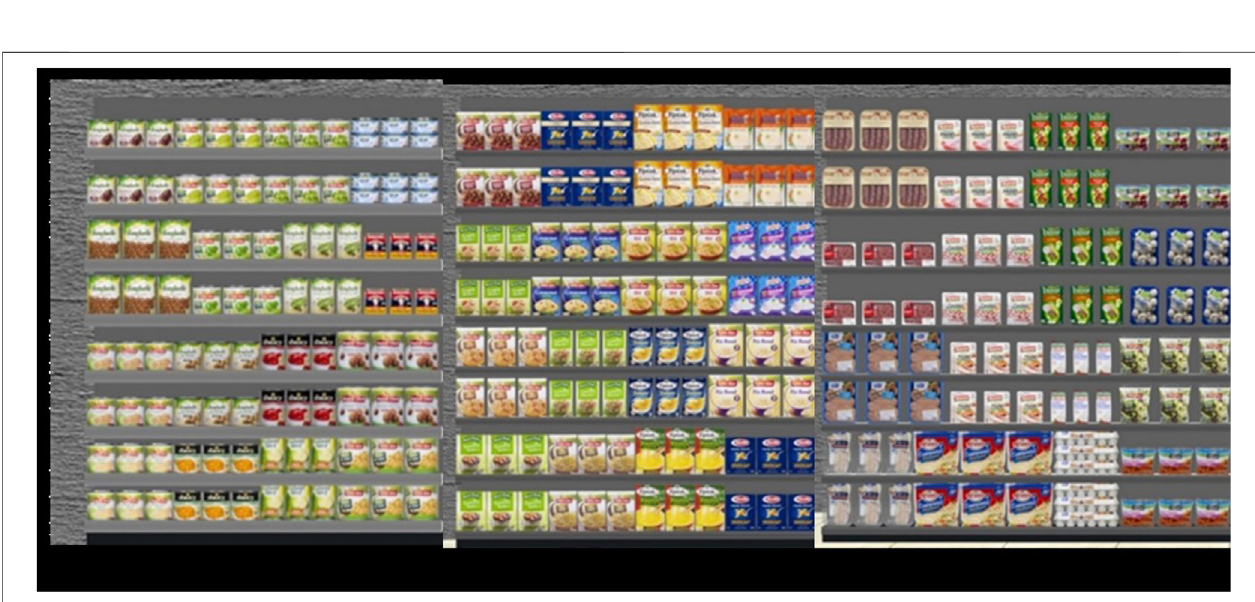
FIGURE 3 | Example of organization of the “ super-shelf. ” From left to right: canned shelf, dried shelf, and refrigerated shelf.